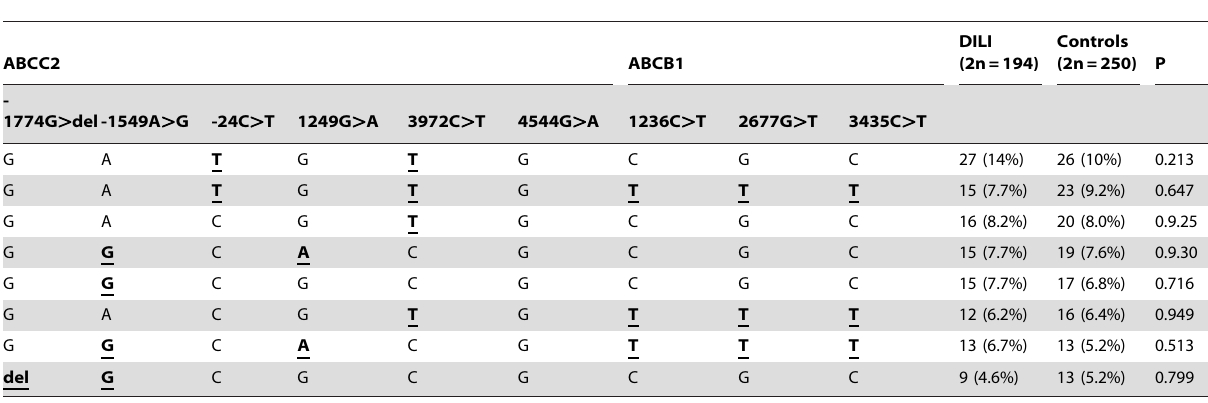
Table 5. Predicted allele combination frequencies of transporter gene polymorphisms.